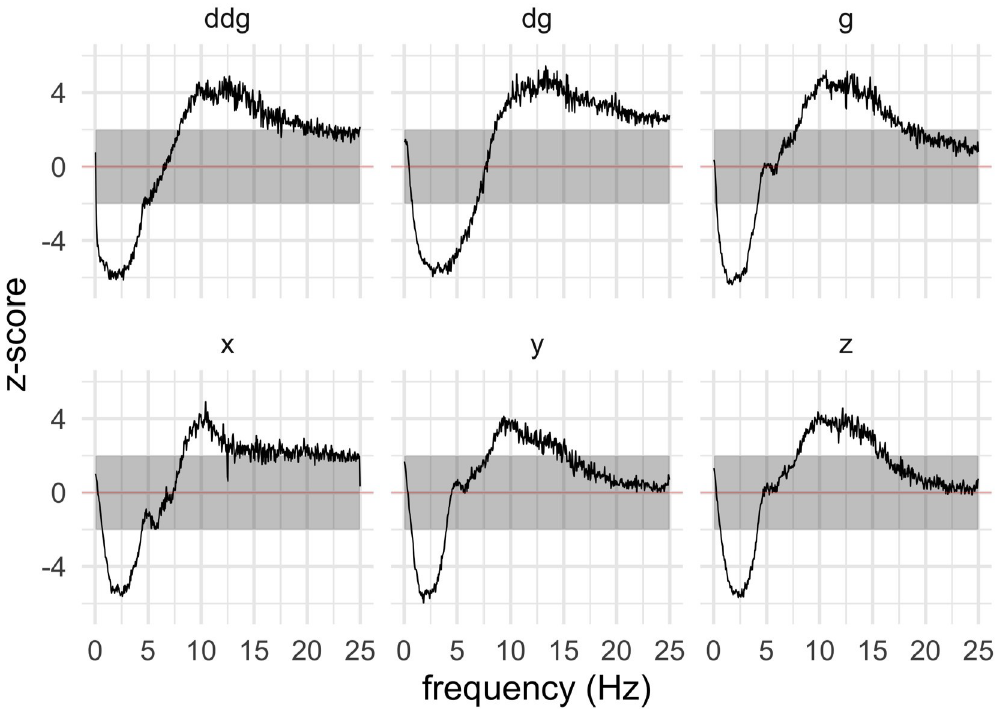
Fig 5. Temporally aggregated power spectra of device and g-aligned channels patients vs. controls.